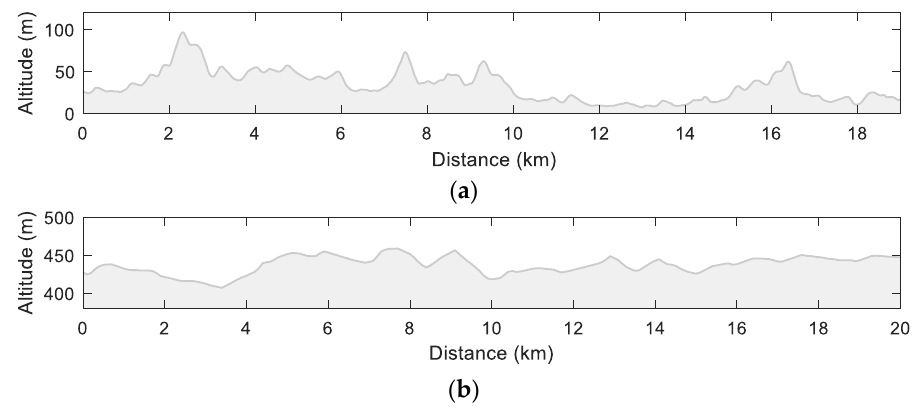
Figure 7. Two testing roads: ( a ) the expressway between Nanjing and Zhenjiang (19 km), and ( b ) the motorway between Chengdu and Chongqing (20 km).